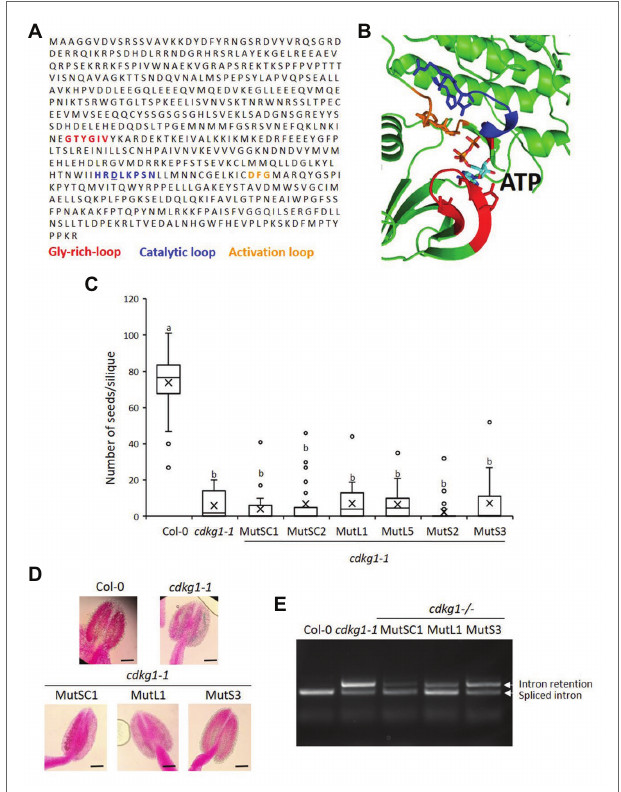
FIGURE 6 | An active kinase is necessary for the function of CDKG1. (A) Sequence of CDKG1 protein. Highlighted are the regions important for kinase activity as indicated. The Aspartic acid (D) residue mutated to Asparagine (N) is underlined. (B) Cartoon representation of the structural model of the CDKG1 active site bound ATP. The Glycine-rich loop is highlighted in red, the catalytic loop blue, the activation loop orange, and ATP light blue. The structure of CDKG1 was rendered using PyMol (http://pymol. org). (C) Fertility counts of the plants transformed with the kinase mutant constructs. The average number of seeds per silique was determined for Col-0, cdkg1-1 and lines expressing the various constructs under the control of the CDKG1 promoter in a cdkg1-1 mutant background as indicated. Data represent average and the interquartile range for 30 siliques from three plants. Superscript letters represent significance groups for p < 0.001. (D) Pollen viability staining of the lines above. Round carmine-colored pollen grains are viable, while white/blue shrunken pollen is not viable. Scale bar = 100 μ m. (E) Splicing profile of the CalS5 mRNA in young inflorescences of the different lines. In the wild type Col-0 only the spliced form is observed, while in the cdkg1-1 mutant both spliced and intron retention are observed. None of the kinase mutant variants is able to rescue the cdkg1-1 mutant splicing